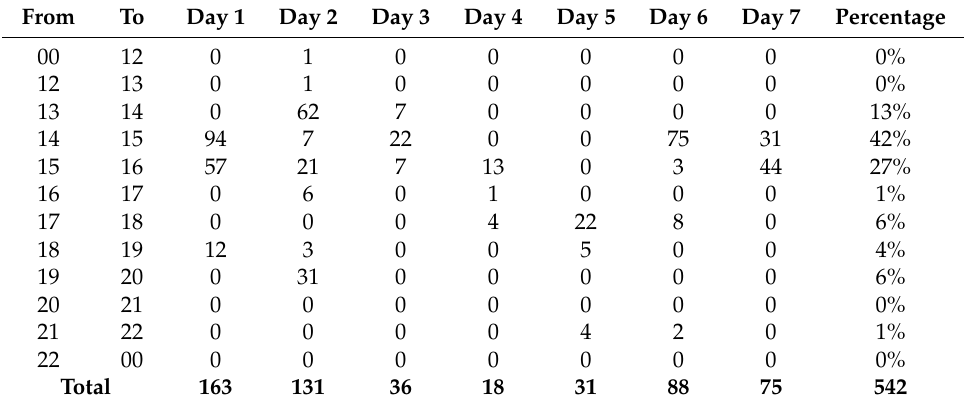
Table 2. Hourly distribution of the commands throughout the days of use of the assistive system.